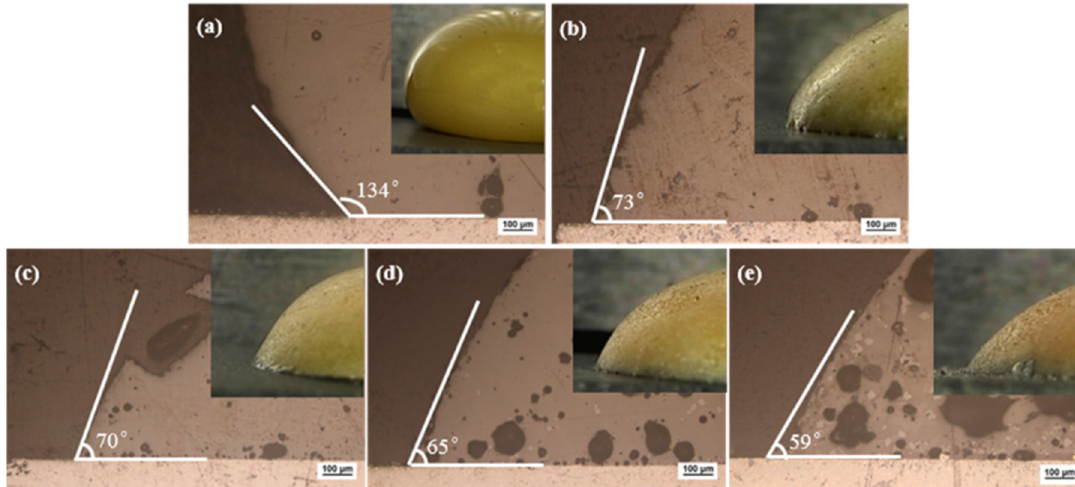
Figure 8. Wetting macro morphology and micro images of brazing filler glass on pre-oxidized hypereutectic Al-50Si alloys at different temperatures for 30 min: ( a ) 475 °C; ( b ) 495 °C; ( c ) 515 °C; ( d ) 535 °C and ( e ) 555 °C.